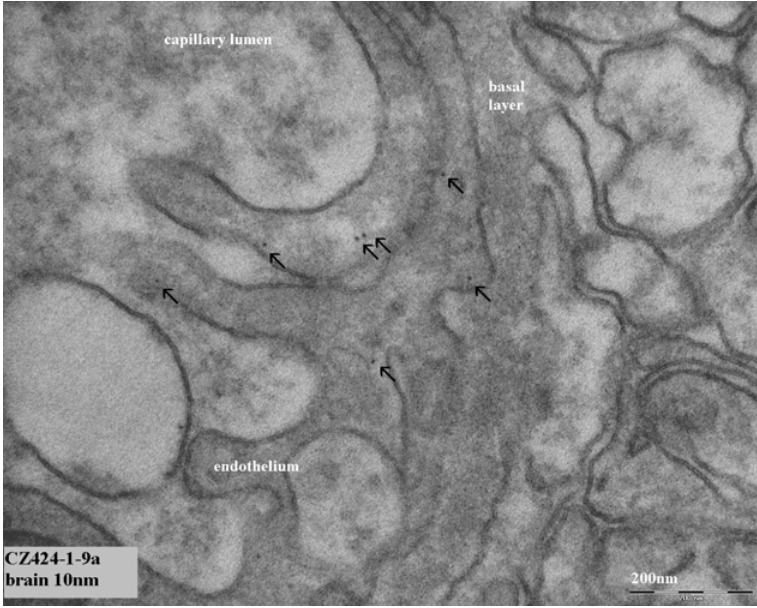
Figure 4. Presence of structures in endothelial cells of the brain. Arrows indicate nanosized (8–10 nm) structures in endothelial cells. The marker indicates 200 nm.